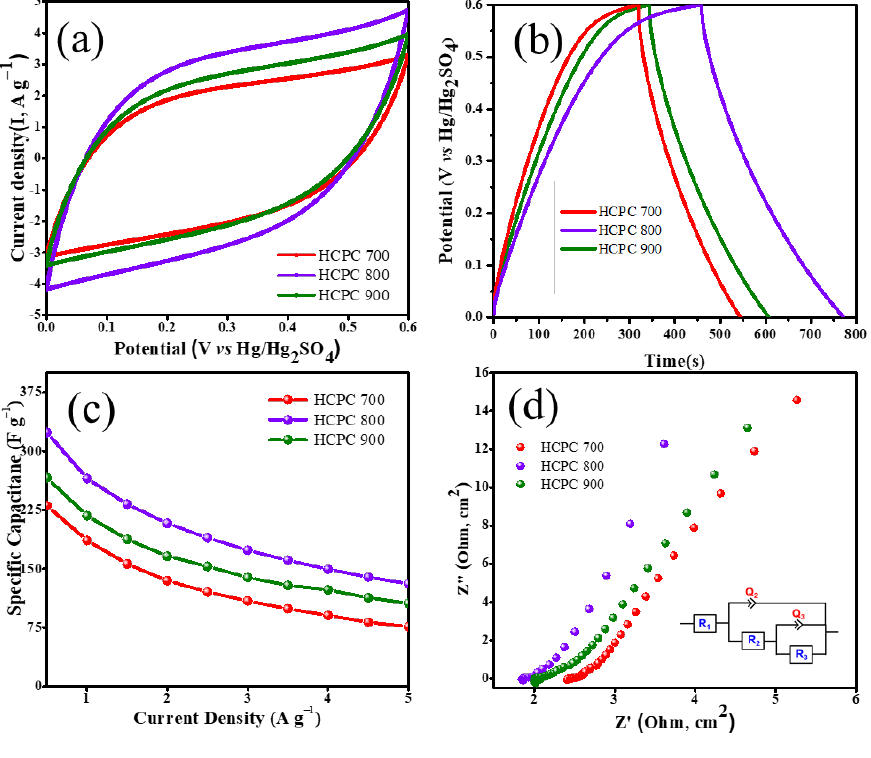
Figure 7. CV ( a ), GCD ( b ), Specific capacitance calculated from GCD ( c ), Nyquist plots ( d ) of HCPC- 700, HCPC-800 and HCPC-900, Cycling stability of HCPC-800 at 5A/g ( e ) and GCD for 1st and 5000th of HCPC-800 ( f ).